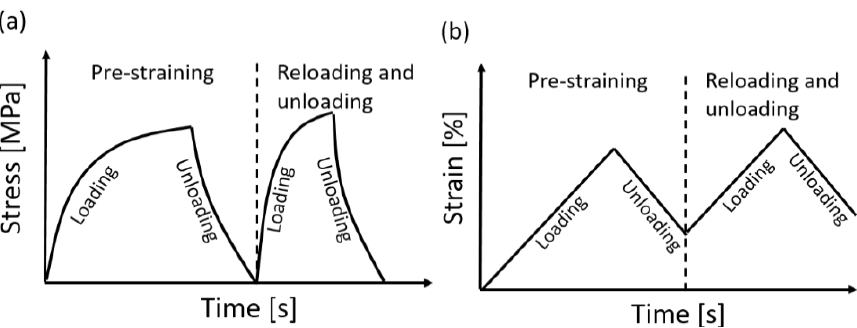
Figure 3. Schematic illustration of the evolution of ( a ) stress and ( b ) strain as a function of time during pre-straining and re-loading experiments for determining E SMA ( κ 0 ) and E SMA ( κ 1 ).